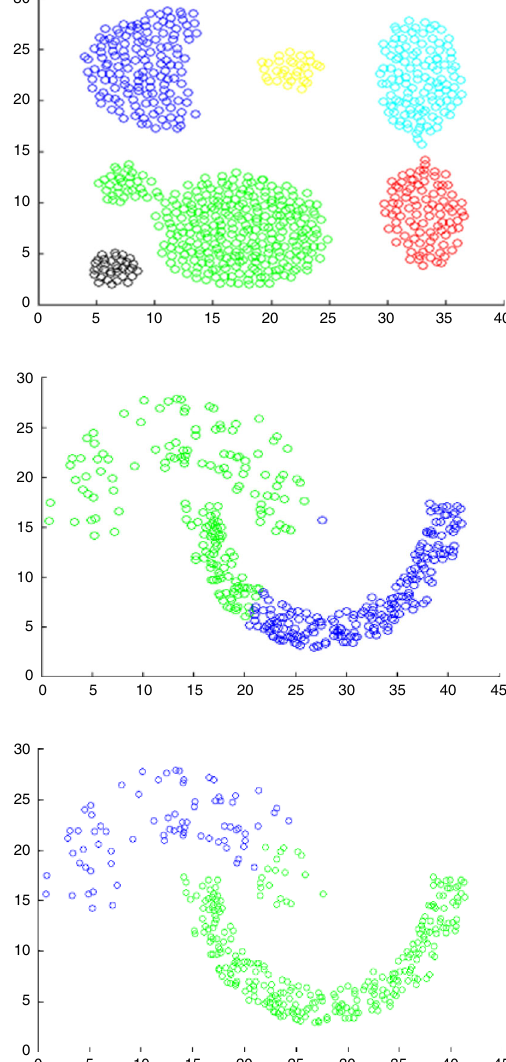
Figure 13. Result of average-link on “ Jain ” data